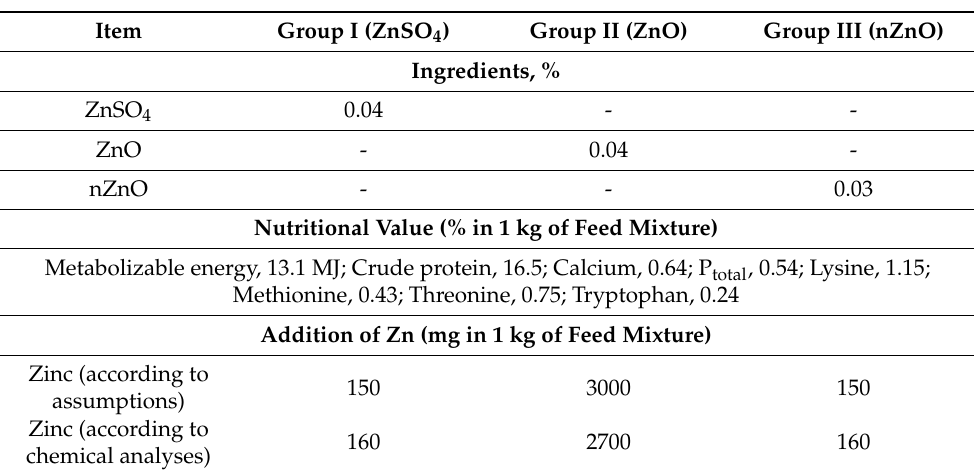
Table 1. Composition * and nutritive value of pre-starter mixtures for